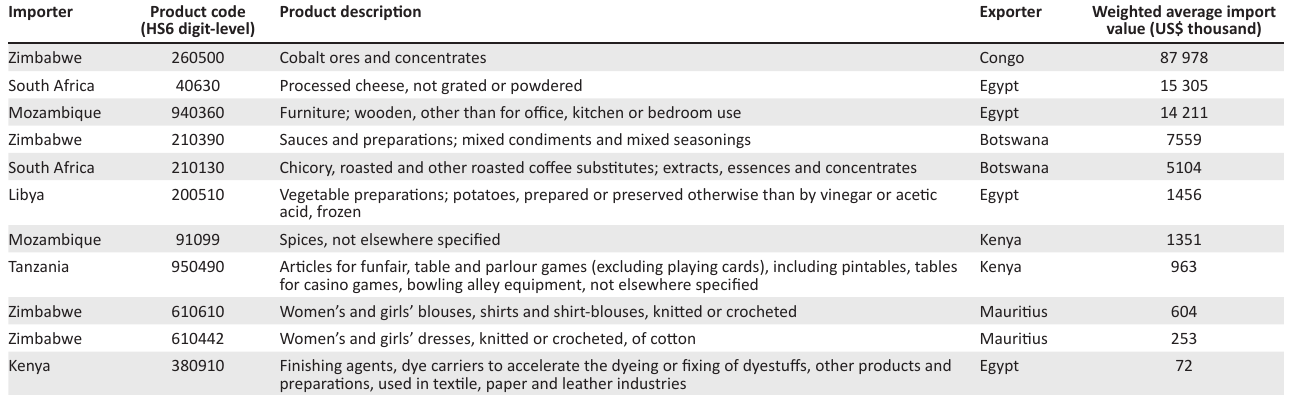
TABLE 7: Importer–product–exporter matches where trade has become extinct (2010–2014).